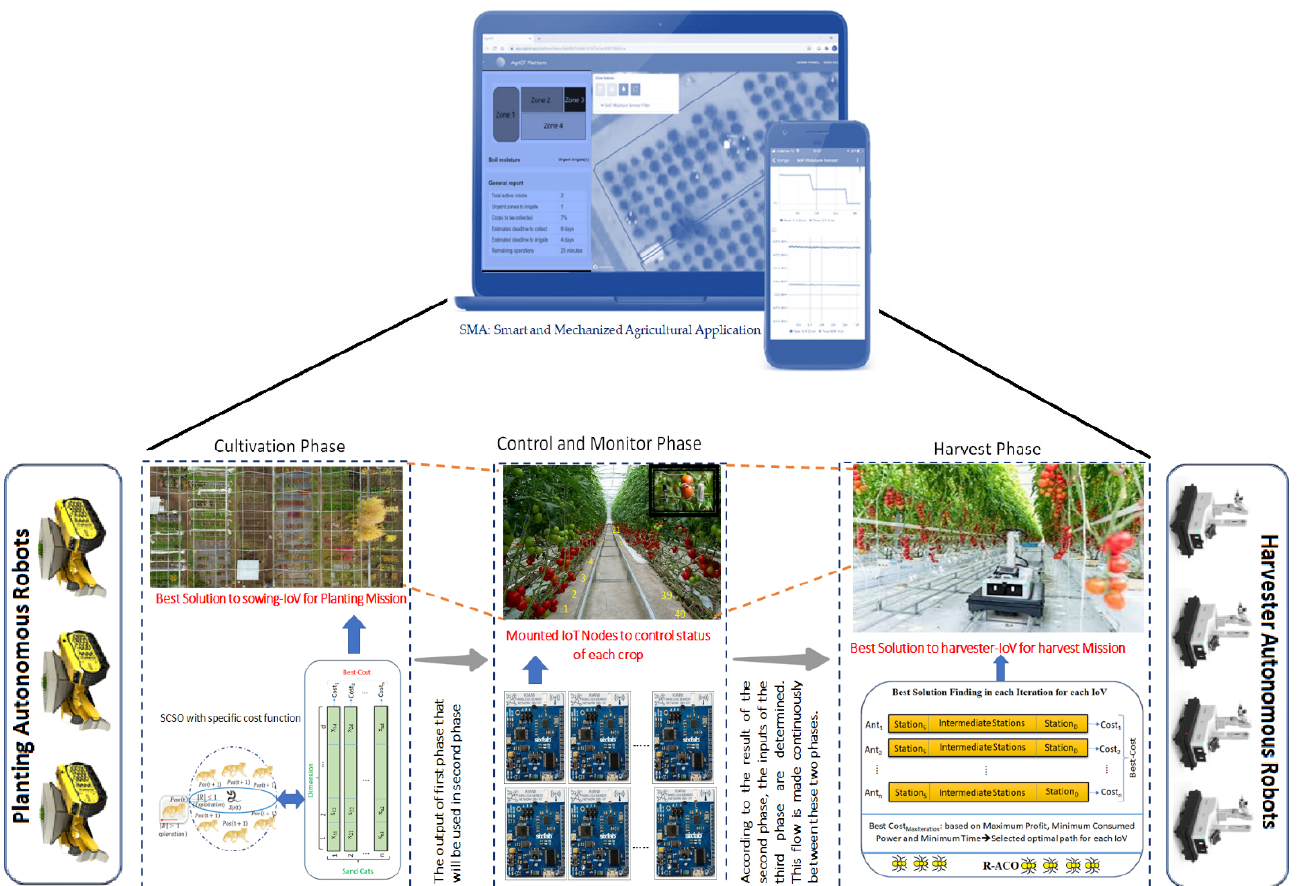
Figure 1. General scheme of all operations of the proposed model.